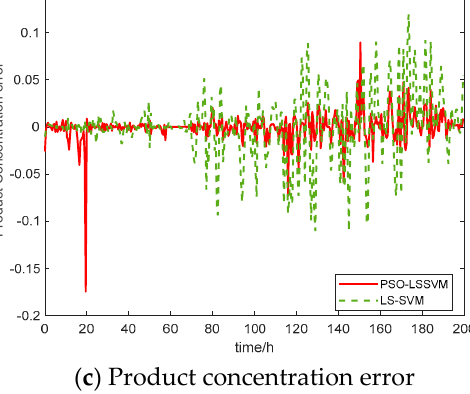
Figure 3. Error curve comparison diagrams.